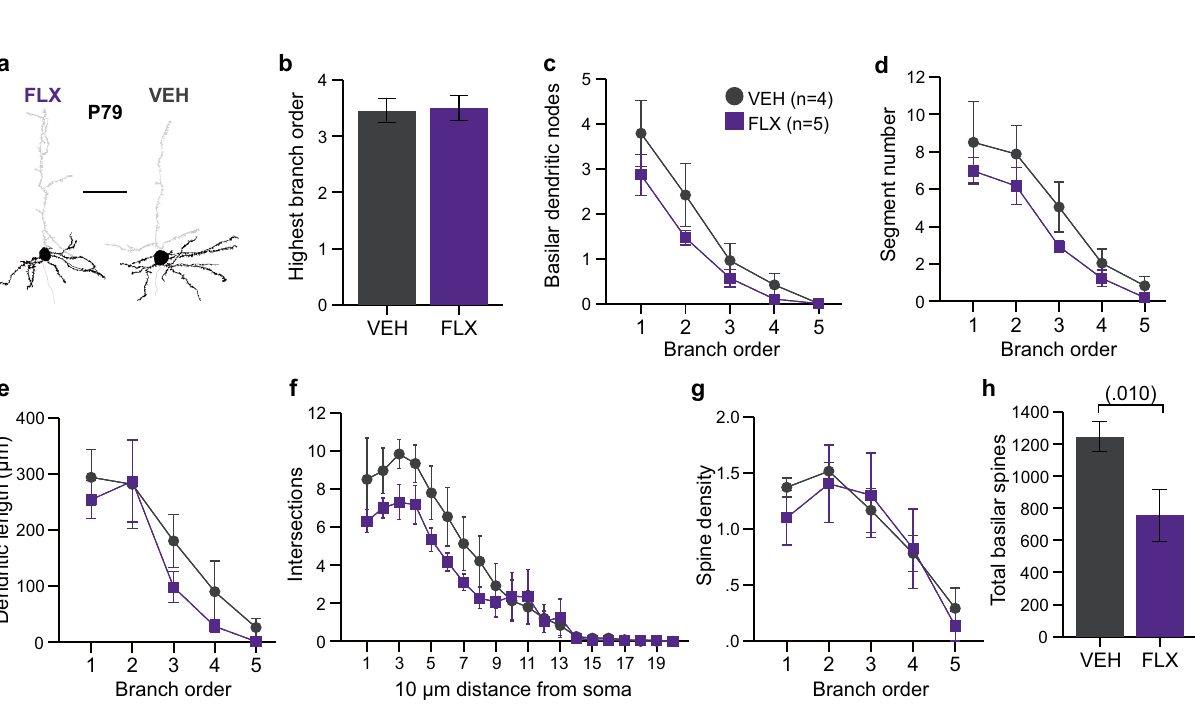
Figure 2. Maternal FLX impact on M1 pyramidal neurons is persistently by decreased by P79. ( a ) Representative tracings of Golgi-Cox impregnated mPFC layer V neurons from P79 FLX and VEH brains. Areas in black indicate quantified basilar dendrites and soma. Scale bar is 50 µm. ( b ) A comparable extent of basilar dendritic branching was observed in P79 VEH- and FLX-exposed neurons of the M1 (n = 10 neurons averaged from 4 VEH mice and n = 10 neurons averaged from 5 FLX mice). ( c-d ) Number of basilar branching nodes and dendritic segments per basilar dendritic branch order were non-significantly reduced in FLX-exposed neurons compared to VEH-exposed neurons at P79. ( e–f ) Basilar dendritic length per branch order and number of intersections per 10 µm distance from the soma were unchanged in FLX-exposed neurons at P79. ( g ) FLX- exposure did not influence spine density per basilar dendritic branch order in P79 neurons. ( h ) Total number of basilar spines was reduced in FLX-exposed neurons compared to VEH-exposed neurons at P79. Data are means ±